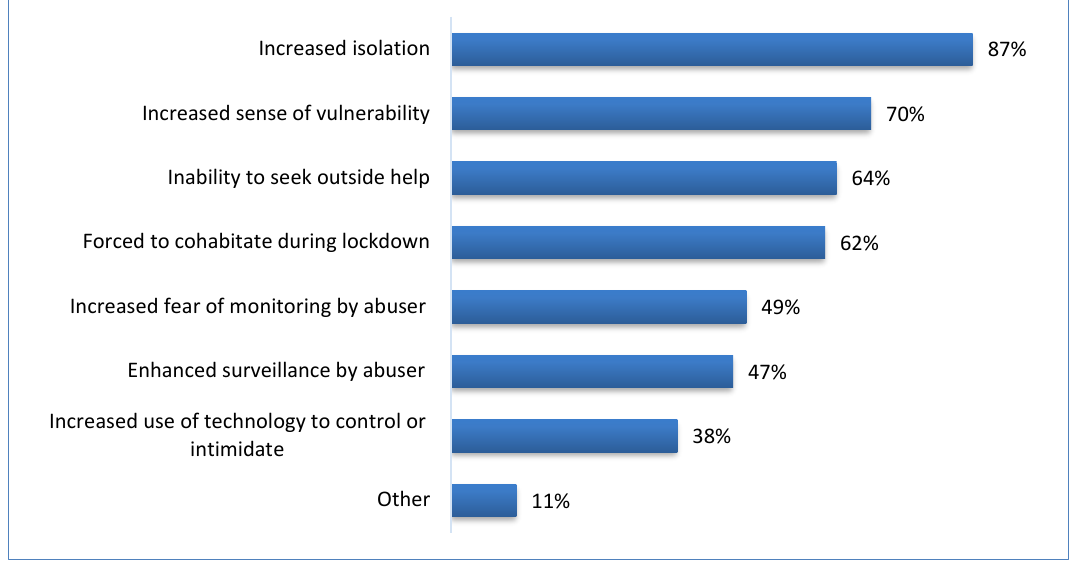
Figure 2. Have any of your clients reporting a DFV matter during the COVID-19 pandemic reported any of the following controlling behaviours?